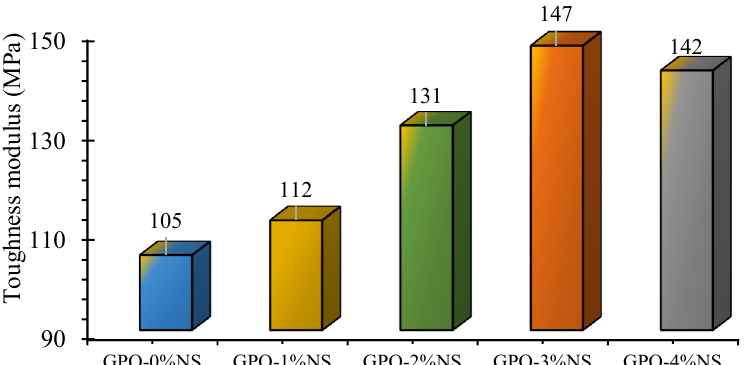
Figure 12. Variation in the modulus of toughness in carbon-fiber-reinforced GPO pastes due to different proportions of NS.